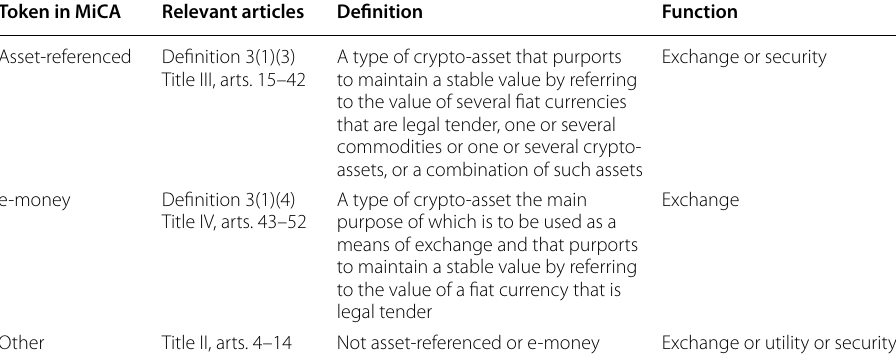
Table 2 Types of tokens in MiCA Token in